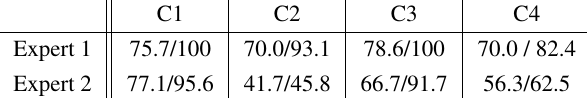
Table 1. Evaluation of configurations (C) by experts. The numbers refer to scores converted into percents. The first number always indicates the overall fitting score and second number evaluation of the